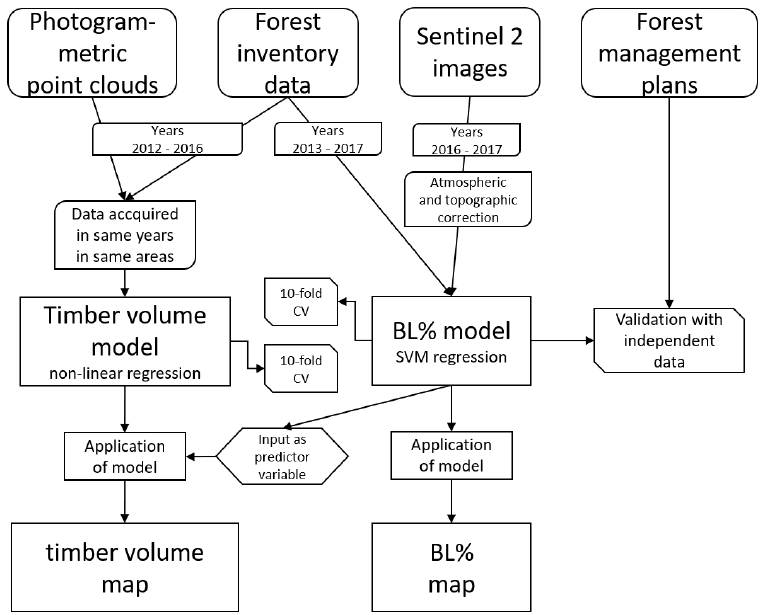
Figure 1. Flow chart depicting the data sets and processing steps. BL%: percentage of broadleaf trees; SVM: support vector machine; CV: cross-validation.